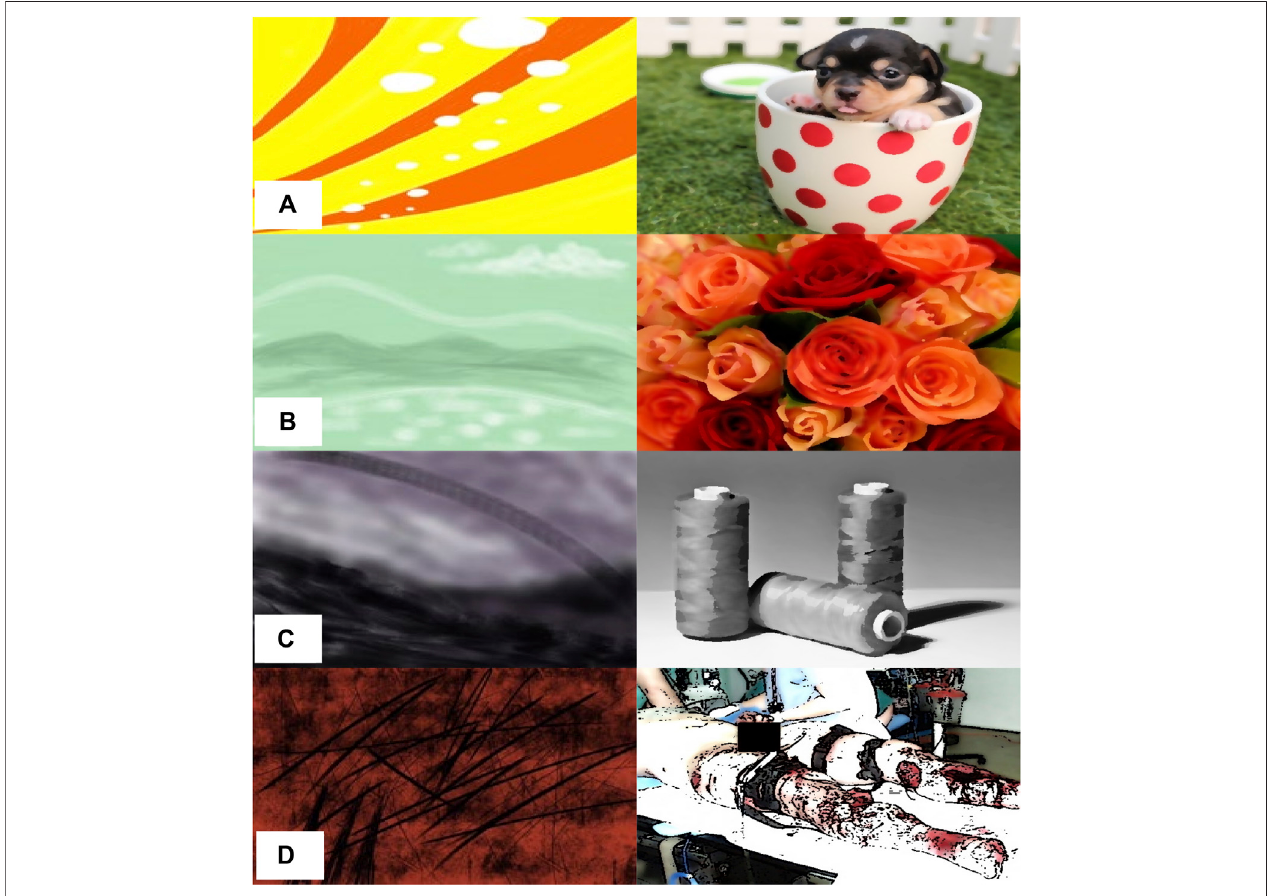
FIGURE 5 | Generic sketches: (left) abstract, (right) representational; (A – B) happy, (C – D) relaxed, (E – F) sad, (G – H) angry.